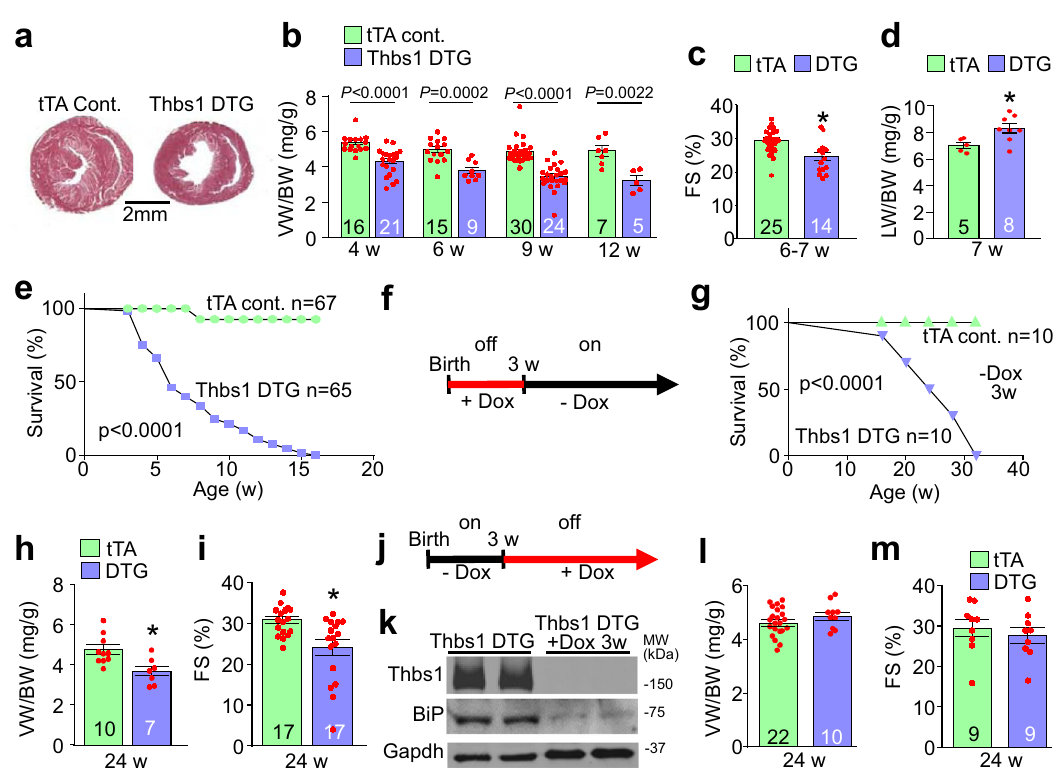
Fig. 2 Cardiomyocyte-speci fi c overexpression of Thbs1 induces lethal cardiac atrophy. a Low magni fi cation images of tTA cont. and Thbs1 DTG whole mount cardiac histological sections stained with Masson ’ s trichrome at 6 weeks of age. Scale bar is 2 mm. b Ventricular weight-to-body weight (VW/BW) ratio at the indicated time points in tTA cont. and Thbs1 DTG mice. P -values are shown in the graph. c Echocardiography measured fractional shortening (FS) percentage in the two groups of mice at 6 – 7 weeks (w) of age. *P = 0.0007 vs tTA cont. d Pulmonary edema was analyzed by lung weight-to-body weight (LW/BW) ratios in the indicated groups of mice at 7 weeks of age. *P = 0.0231 vs tTA cont. e Kaplan – Meier survival plot of tTA cont. and Thbs1 DTG animals with continuous Thbs1 expression (never Dox; P < 0.0001 vs tTA cont.). f Experimental regimen of early Dox administration to inhibit Thbs1 transgene expression during embryonic and early postnatal development in Thbs1 DTG animals (Dox was removed at 3w of age). g Kaplan – Meier survival plot of tTA cont. and Thbs1 DTG mice treated with Dox as shown in panel “ f ” ( P < 0.0001 vs tTA cont.). h VW/BW ratio and i FS percentage at 24 weeks of age given the treatment regimen shown in panel “ f ” . *P = 0.0073 vs tTA cont. for “ h ” and *P = 0.0039 vs tTA cont. for “ i ” . j Schematic diagram for administration of Dox beginning at 3 weeks of age to shut down Thbs1 expression thereafter (Dox was given at 3w and beyond). k Representative Western blots of protein extracts from hearts of Thbs1 DTG mice at 8 weeks of age in Thbs1 DTG mice as shown in panel “ j ” , assayed for Thbs1, BiP, and Gapdh as a loading control. l VW/BW ratio and m FS percentage at 24 weeks of age in the mice treated as shown in panel “ j ” . The number of biologically independent animals analyzed is indicated on each graph. Statistical analysis was performed using two-tailed Student ’ s t test ( b – d , h , i , l , m ), or survival analysis by two- tailed log-rank test ( e , g ). Error bars are ±standard error of the mean. Source data are provided as a Source Data